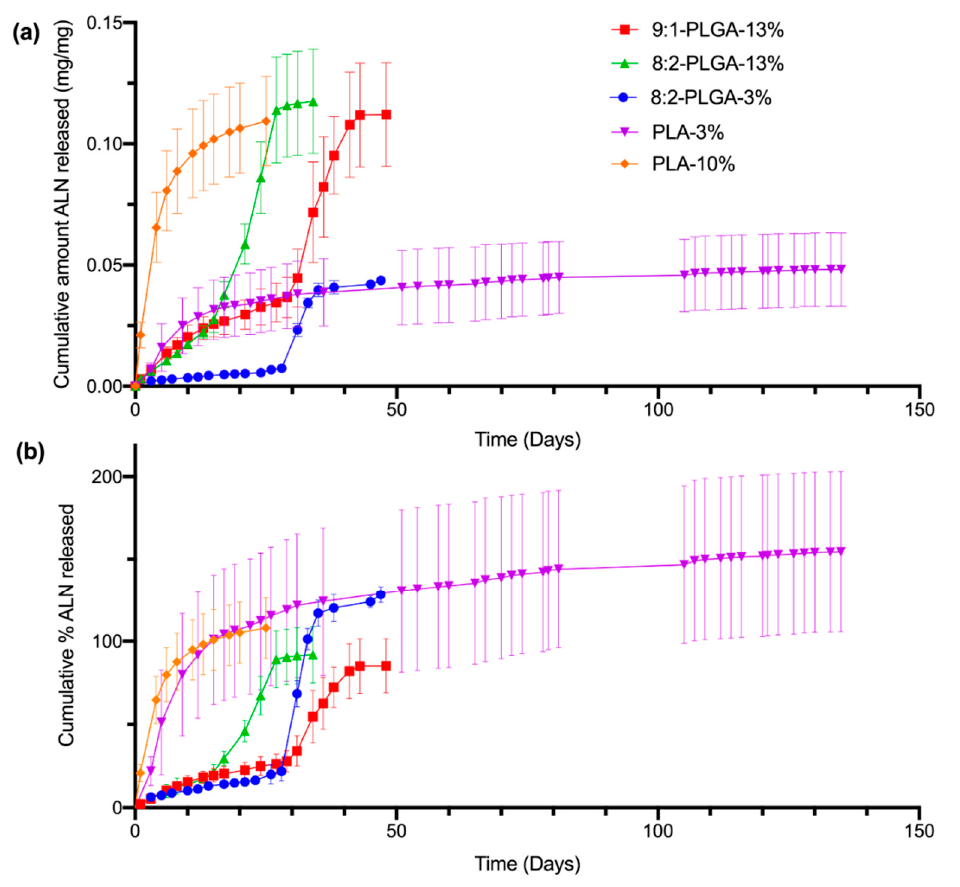
Figure 3. Comparison of the in vitro cumulative amount (mg / mg) of ALN released ( a ) and cumulative % of ALN released ( b ) from all investigated implant formulations in PBS (pH 7.4) at 37 °C. The poly(D,L-lactide- co -glycolide) (PLGA) and poly(lactic acid) (PLA) implants demonstrate sigmoidal and logarithmic release profiles, respectively. The total ALN-loading of the implants was calculated from the values listed in Table 2, resulting in percent values that appear to exceed, or plateau below, 100% (for further discussion, see Section 3.4). The values shown represent mean ± SD of n = 4 for 8:2-PLGA-13% and n = 5 for the remaining implant formulations. Polymers 2020 , 12 , x FOR PEER REVIEW 10 of 15